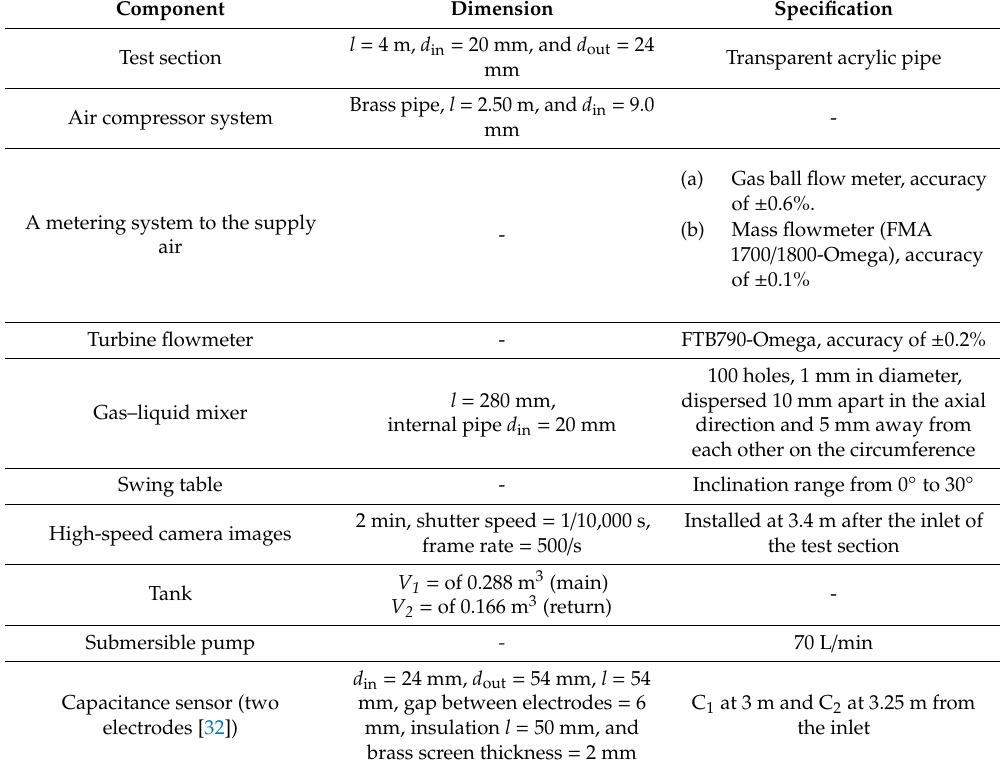
Table 2. Summary of the experimental apparatus’s components, dimensions and